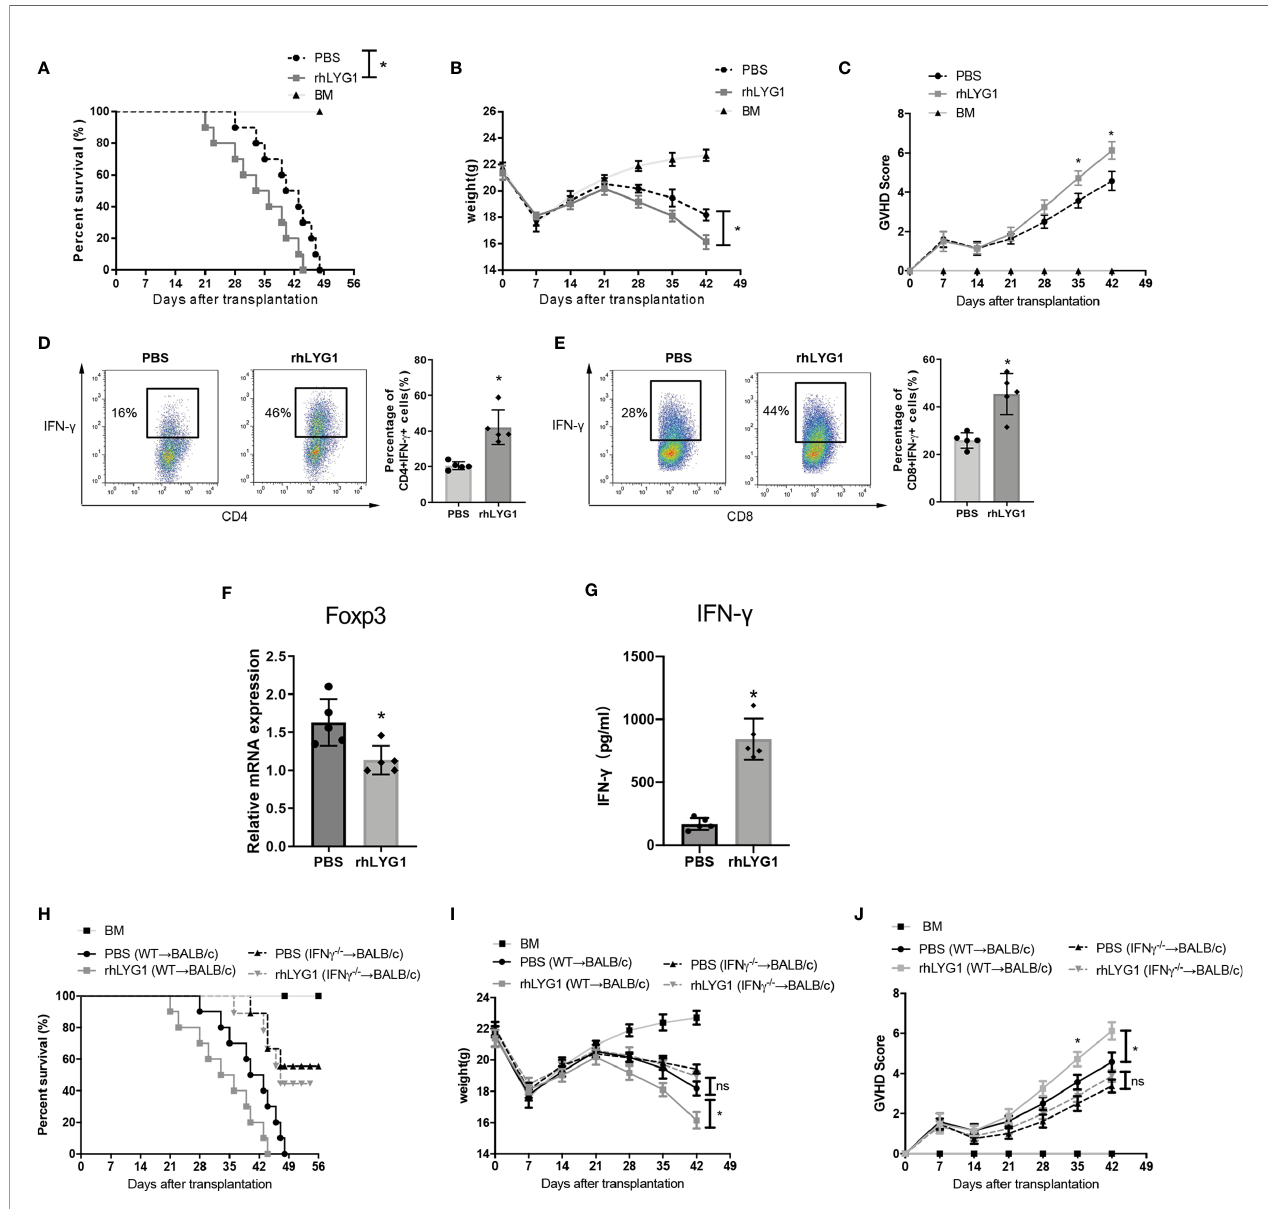
FIGURE 7 | rhLYG1 aggravates aGVHD via promoting IFN- g production and inhibiting Foxp3 expression. (A – C) Lethally irradiated BALB/c mice were reconstituted with 5 × 10 6 B6 BM and 3 × 10 6 B6 CD3 + T cells, rhLYG1 (20 m g per mice) or PBS was injected intraperitoneally (i.p.) each day on days 0 to +7 after transplantation. Survival (A) , weight (B) and aGVHD scores (C) were monitored. (D, E) The percentages of IFN- g positive gated on H2Kb+CD4+ T cells and H2Kb+CD8+ T cells in spleens at day 7 after transplantation. (F) Foxp3 expression of splenocytes were examined by qPCR at day 7 after transplantation. (G) The concentrations of IFN- g in serum at day 7 after transplantation. (H – J) Lethally irradiated BALB/c mice were reconstituted with 5 × 10 6 B6 BM and 3 × 10 6 IFN- g -/- CD3 + T cells, rhLYG1 (20 m g per mice) or PBS was injected intraperitoneally (i.p.) each day on days 0 to +7 after transplantation. Survival (H) , weight (I) and aGVHD scores (J) were monitored. (A – C, H – J) Data pooled: n = 10 for PBS group and rhLYG1 group, n = 5 for BM group. (D – G) Independent experiment was performed 3 times. The results in the repeats were similar. n = 5 per group. Representative plots are shown and statistical results are expressed as the mean ± SD, *p < 0.05 compared with PBS group. ns, no signi fi